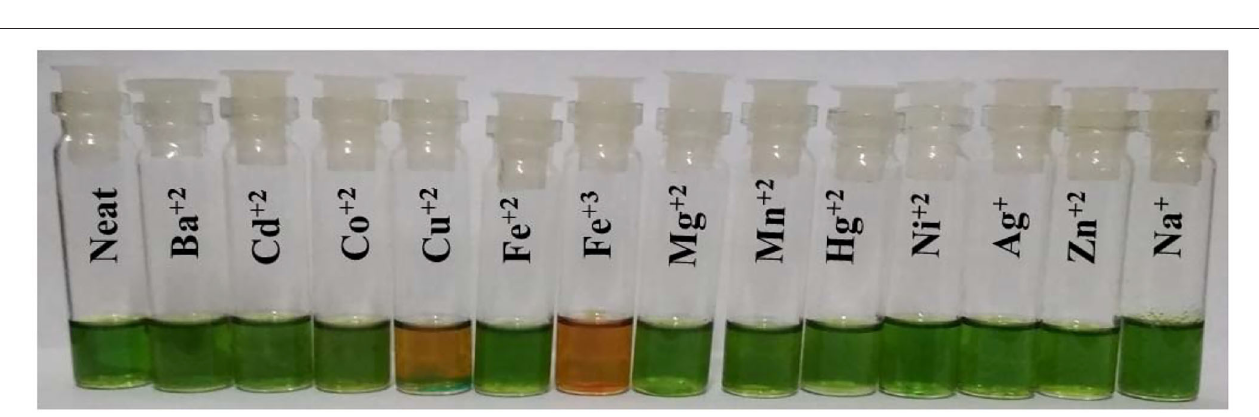
FIGURE 9 | Colorimetric studies of 2 using 4 equiv. of various cations in CHCl 3 at